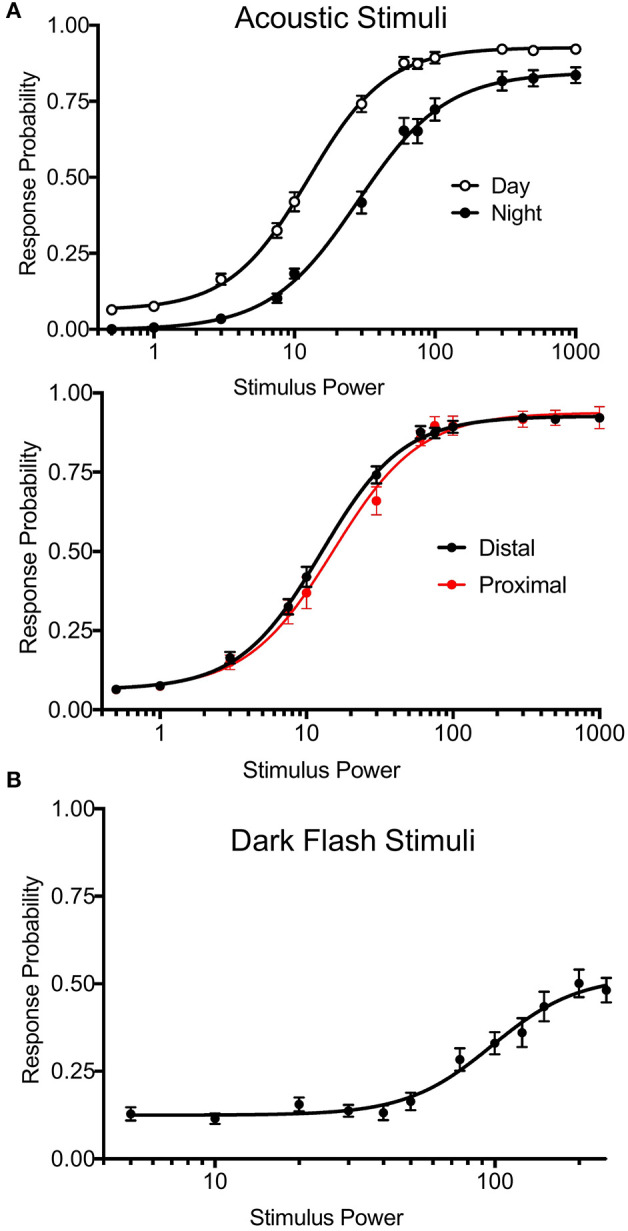
Precise Stimulus Control. (A)
Top: Acoustic stimulus (20 ms, 625 Hz, square wave-form) response curves for wild-type larvae during night and day. Night arousal threshold = 31.43, Day arousal threshold = 13.17. N = 54 larvae, p < 0.0001, extra sum-of-squares F test. Bottom: Daytime acoustic stimulus response curves comparing location relative to the transducer. Proximal group includes larvae in the three rows closest to the transducer. Proximal threshold = 15.19, distal threshold = 12.57, p = 0.0743, extra sum-of-squares F test. Stimulus power indicates amplitude of sound from surface transducer on log scale. (B) Dark flash stimulus response curve for wild-type animals. Responses were filtered to include only O-bend startle responses. Stimulus power indicates difference in voltage delivered to light panel relative to baseline illumination.